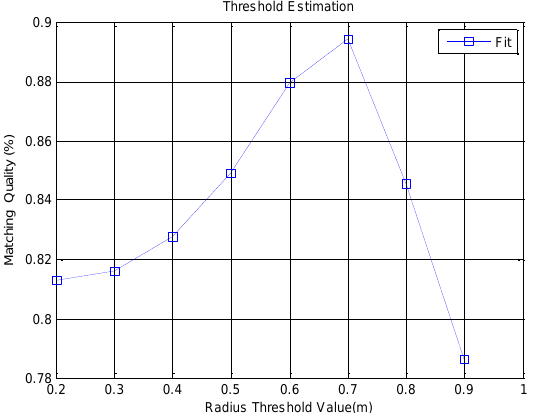
Figure 3: Threshold value and quality measure for